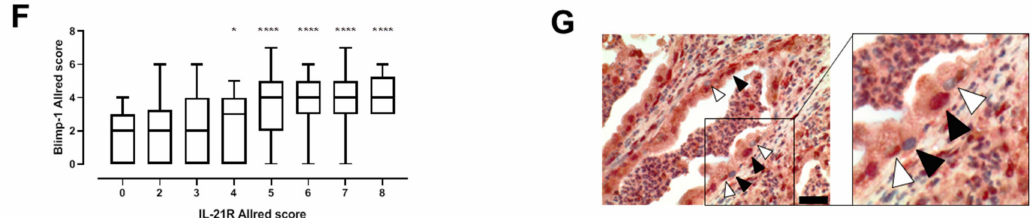
Figure 1. IL-21R, IL-21, and Blimp-1 expression in human PDAC and healthy pancreas tissue samples. ( A ) Infiltration of IL-21 + immune cells (red) in PDAC. Black arrow: IL-21 + cells. ( B ) Infiltration of IL-21 + Th17 cells in PDAC: IL-21 + (red) and RORC + (brown) cells. Black arrowhead: PDAC tumor cells, black arrow: IL-21 + / RORC + immune cells. ( C ) Examples of negative, weak and high expression of IL-21R (brown) and Blimp-1 (red) in human PDAC tissue. Black arrows: tumor cells. ( D ) Examples of IL-21R and Blimp-1 expression in healthy pancreas tissue. ( E ) IL-21R expression in human PDAC varied among the patients. ( F ) Association of IL-21R and Blimp-1 expression in human PDAC. * P < 0.05 and **** P < 0.0001. Unpaired t -test. ( G ) Co-expression of IL-21R (brown, membrane) and Blimp-1 (red,